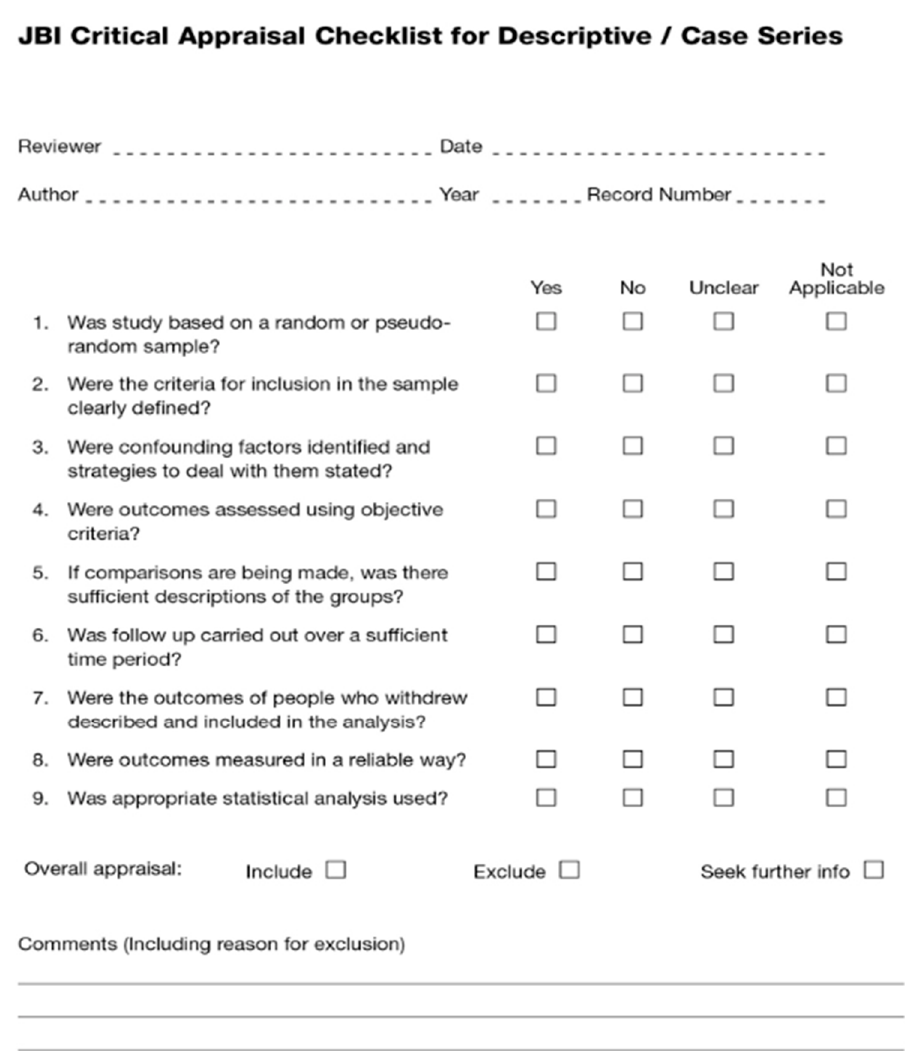
Figure A1. JBI Critical Appraisal Checklist for Descriptive / Case